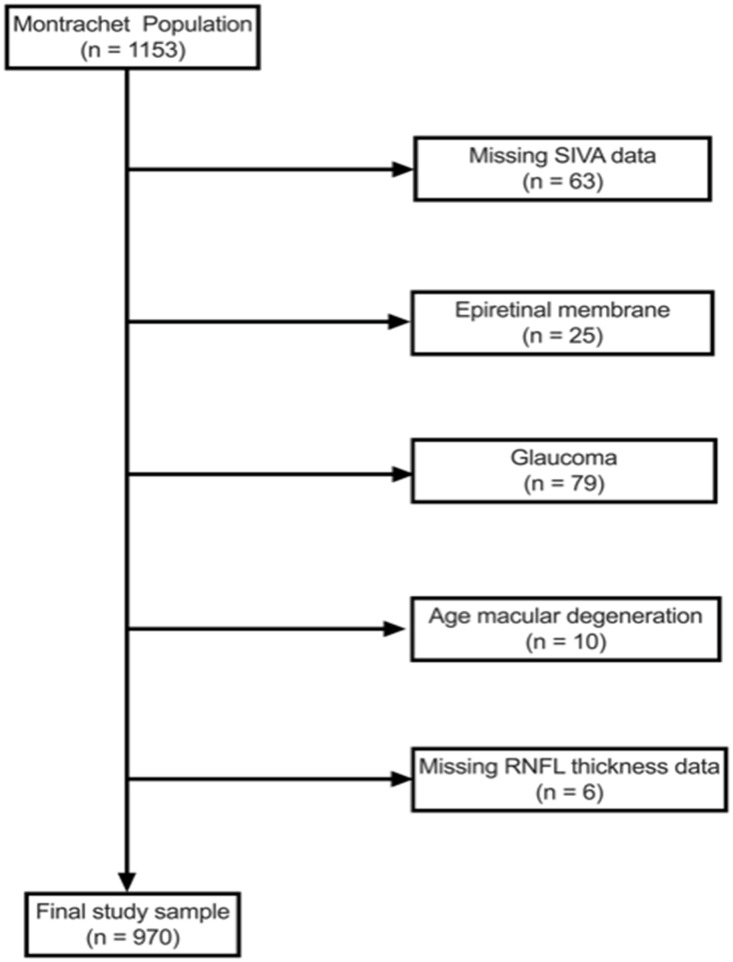
Flow chart of the study.SIVA, Singapore “I” Vessel Assessment; RNFL, retinal nerve fiber layer. Only patients with late age-related macular degeneration and modification of the vascular architecture in zone B and C were excluded.